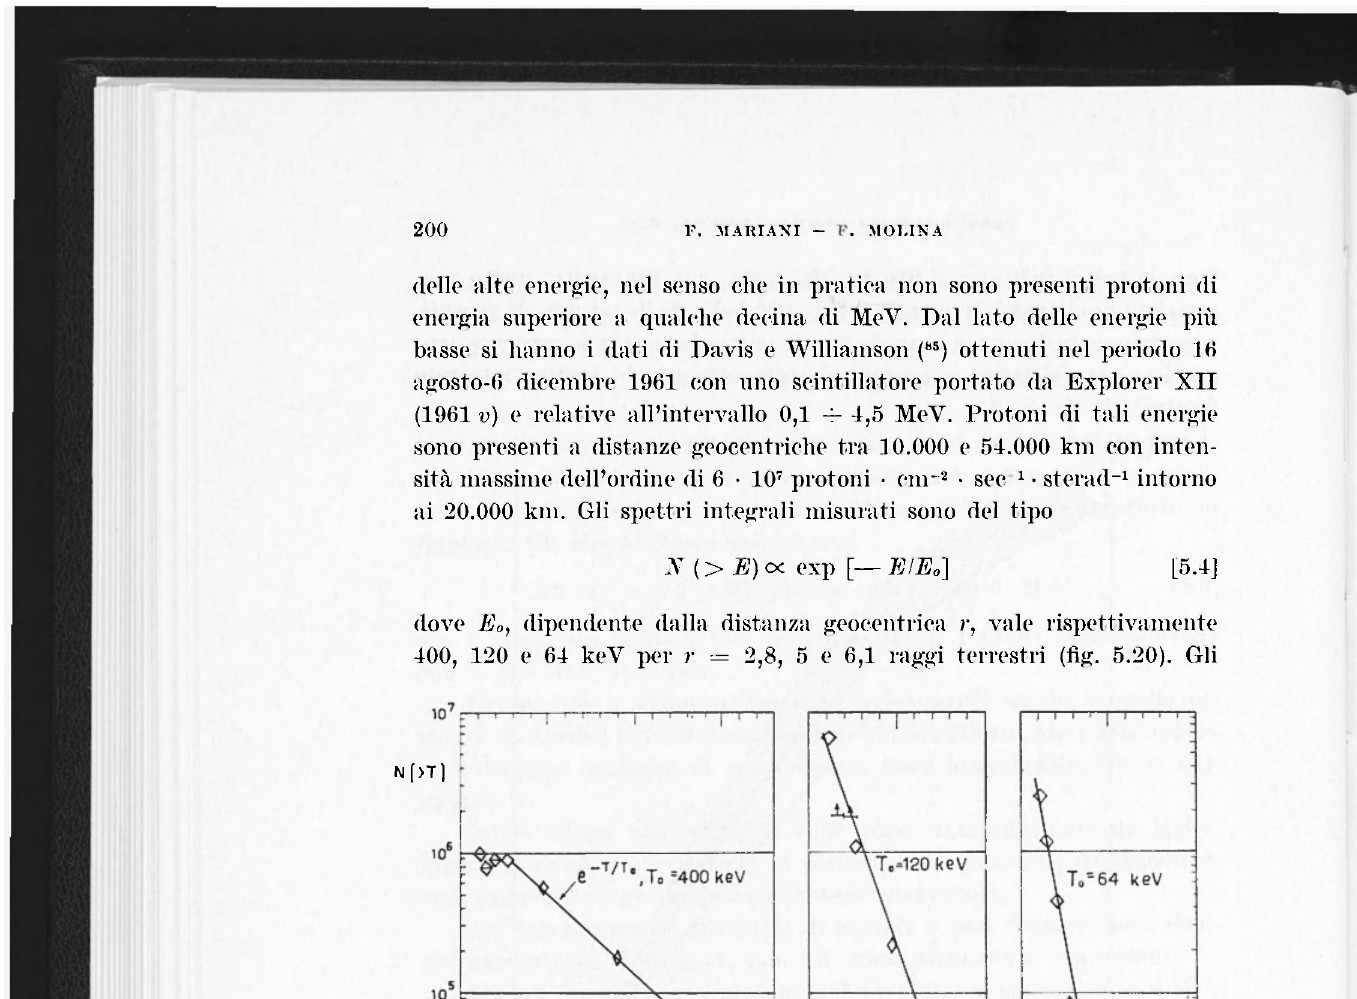
Fig. 5.20 — Spettro integrale di protoni (in protoni-cm -2 -sec -1 -sterad -1 ) a varie distanze r (in raggi terrestri) e alle latitudini geomagne- tiche 0 indicate (secondo Davis e